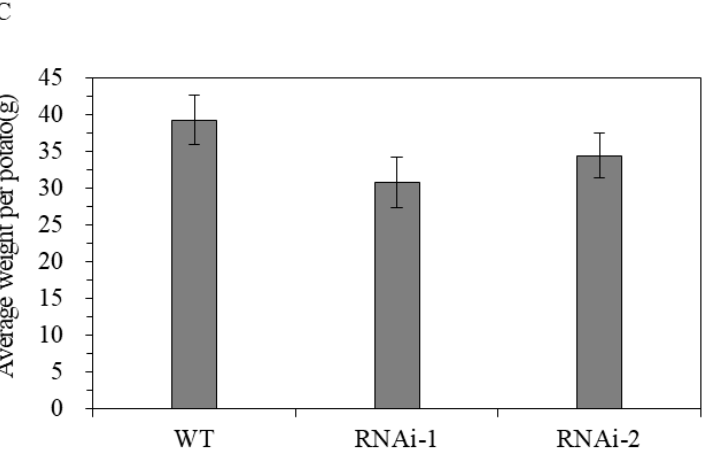
Figure 7. Effects of StSUT2-RNAi on potato tuber yield ( A ), number ( B ), and size ( C ). “*” means the difference is statistically significant between RNAi lines and WT.